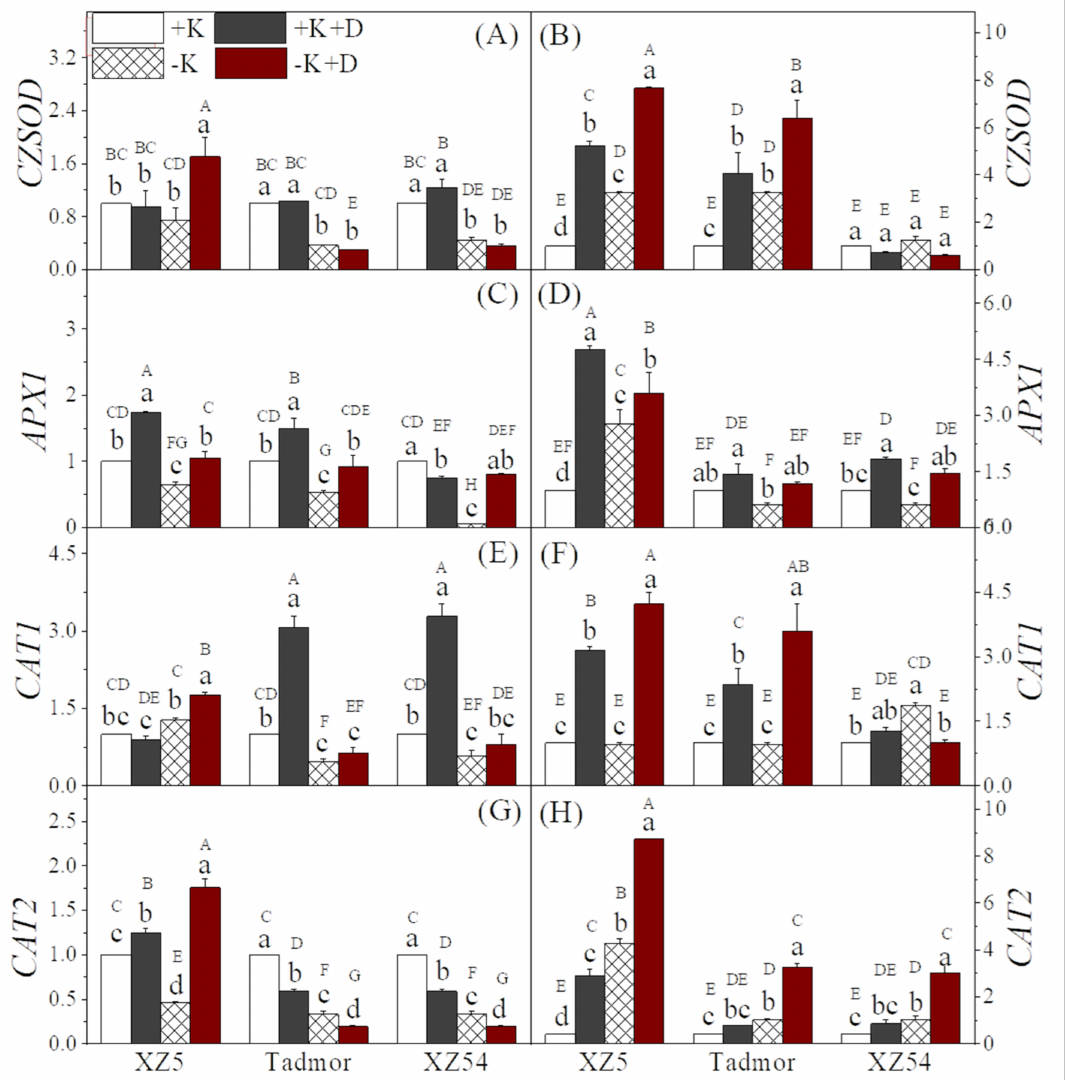
Figure 5. Antioxidant enzyme related gene expression analyzed by qRT-PCR in Tibetan wild barley XZ5 and XZ54, and cv. Tadmor. Barley plants were exposed to alone and combined stresses of drought and K+ deprivation on CZSOD, APX1, CAT1 and CAT2 gene expression study in leaves ( A , C , E , G ) and roots ( B , D , F , H ) of three barley genotypes, XZ5, Tadmor and XZ54. Different capital and small letter(s) indicate significant differences ( p < 0.05) among the genotypes and among the 4 treatments within each genotype, respectively. Error bars represent standard deviations ( n = 4). +K, +K+D, –K, and –K+D, correspond to basic nutrition solution with normal K of 1 mM K (BNS), BNS + 20% Polyethylene glycol 6000 (PEG), BNS without K (K deprivation), and BNS without K + PEG,